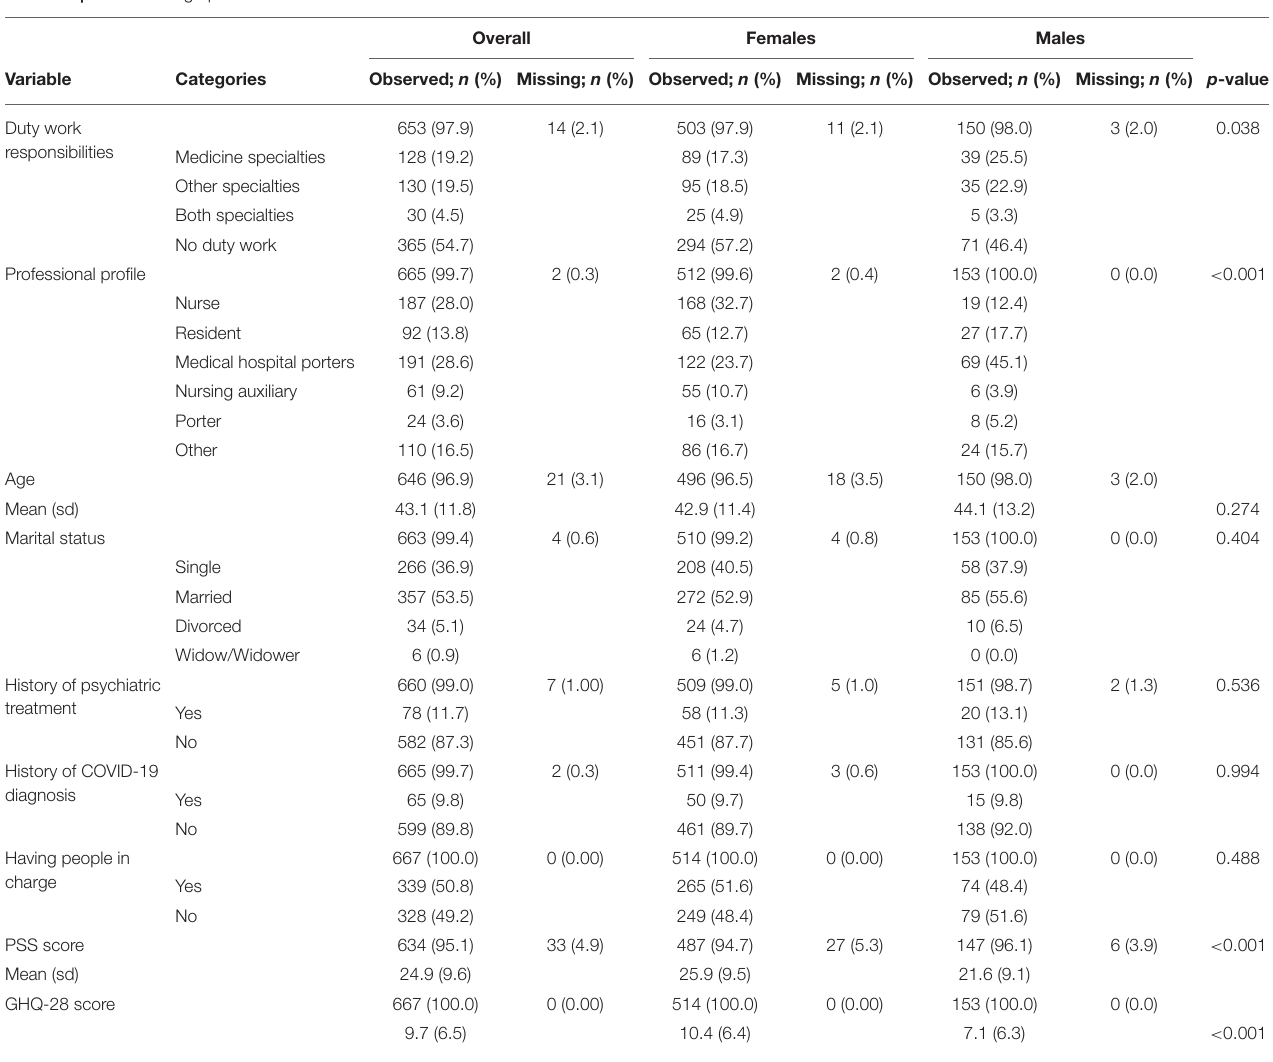
TABLE 1 | Socio-Demographic